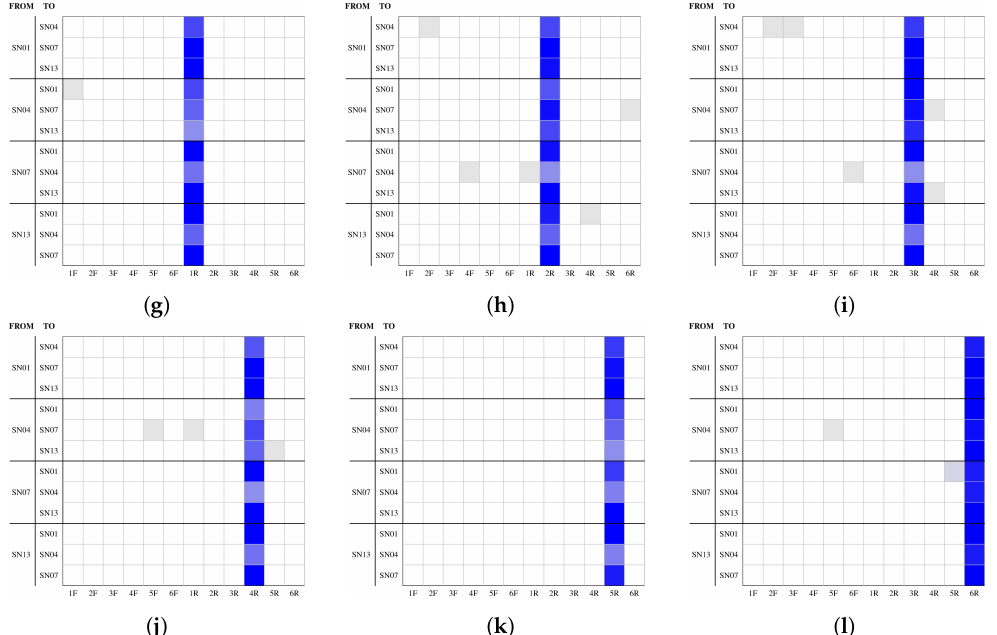
Figure 7. Inter-layer user profile linking results: each graph groups the results of a single source on all thirteen SNs, six for the front cameras ( a – f ) and six for the rear cameras ( g – l ); the number of images in each cell is identified through a white-to-blue scale, from 0 (white) to 17